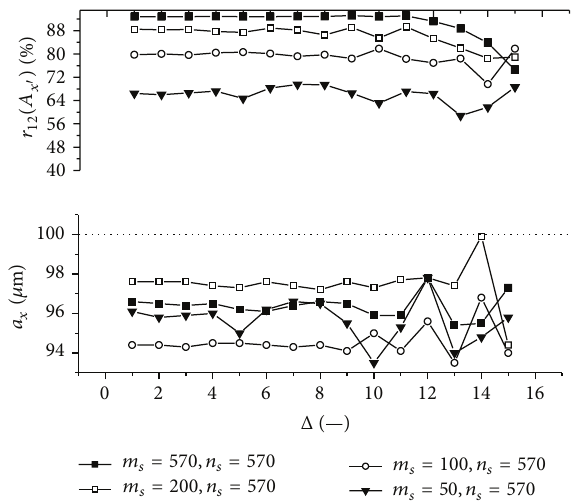
Figure 12: The evaluated object’s translation component 𝑎 𝑥 as well as the maximum 𝑟 12 (𝐴 𝑥 󸀠 ) of the 1D normalized cross-correlation function of intensity signals 𝐼 1 and 𝐼 2 acquired from decimated 2D intensity signals of various size as a function of the factor Δ . Mean speckle sizes are 𝛼 𝑥 󸀠 = 264.9 𝜇 m and 𝛼 𝑦 󸀠 = 225.5 𝜇 m. The object is translated by 𝑎 𝑥 = 100 𝜇 m and 𝑎 𝑦 = 100 𝜇 m.